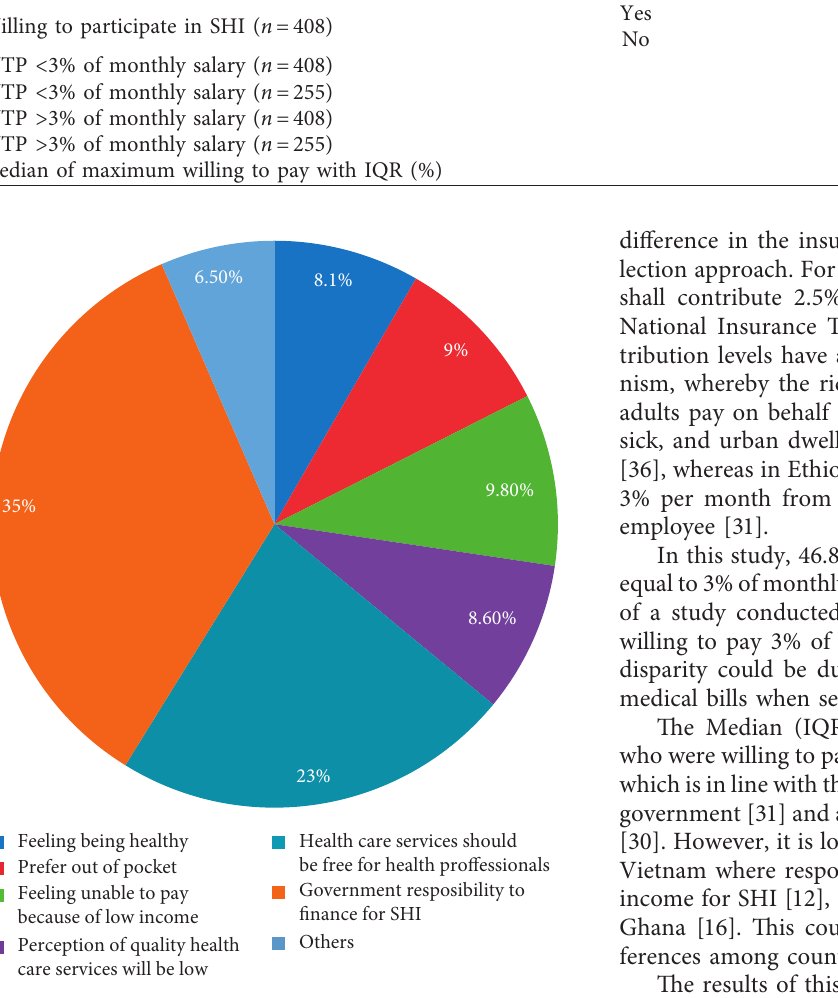
Figure 2: Reasons for not accepting social health insurance among health professionals in government hospitals, Mekelle City, North Ethiopia,